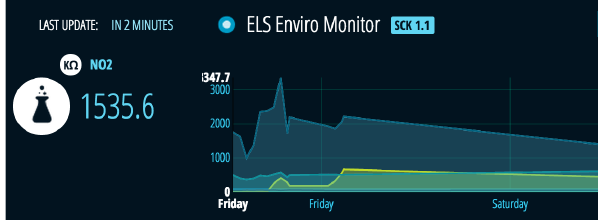
Figure 3: Air quality data displayed on the Smart Citizen online